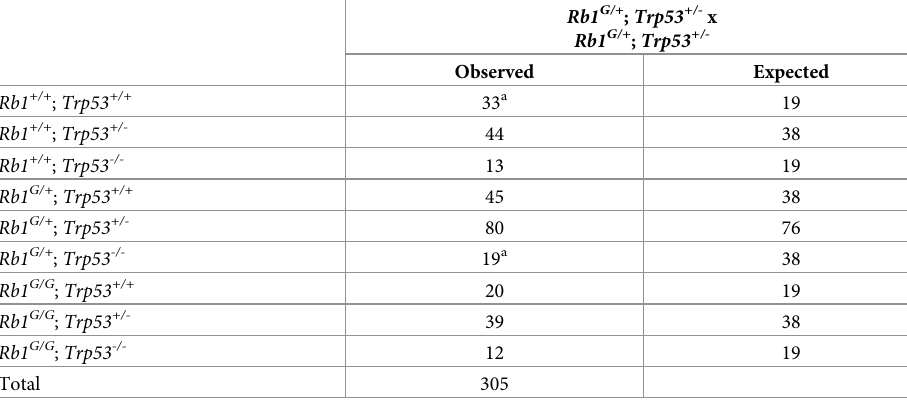
Table 1. Frequency of generating Rb1 G ; Trp53 -/- compound mutant mice. Rb1 G/+ ; Trp53 +/- x Rb1 G/+ ; Trp53 +/- Observed Expected Rb1 +/+ ; Trp53 +/+ 33 a 19 Rb1 +/+ ; Trp53 +/- 44 38 Rb1 +/+ ; Trp53 -/- 13 19 Rb1 G/+ ; Trp53 +/+ 45 38 Rb1 G/+ ; Trp53 +/- 80 76 Rb1 G/+ ; Trp53 -/- 19 a 38 Rb1 G/G ; Trp53 +/+ 20 19 Rb1 G/G ; Trp53 +/- 39 38 Rb1 G/G ; Trp53 -/- 12 19 Total 305 The indicated genotypes of mice were crossed and all resulting progeny were genotyped. The number of live animals observed at two weeks of age is indicated for each genotype and the expected number based on Mendelian inheritance is indicated. a denotes significance as determined by chi-squared